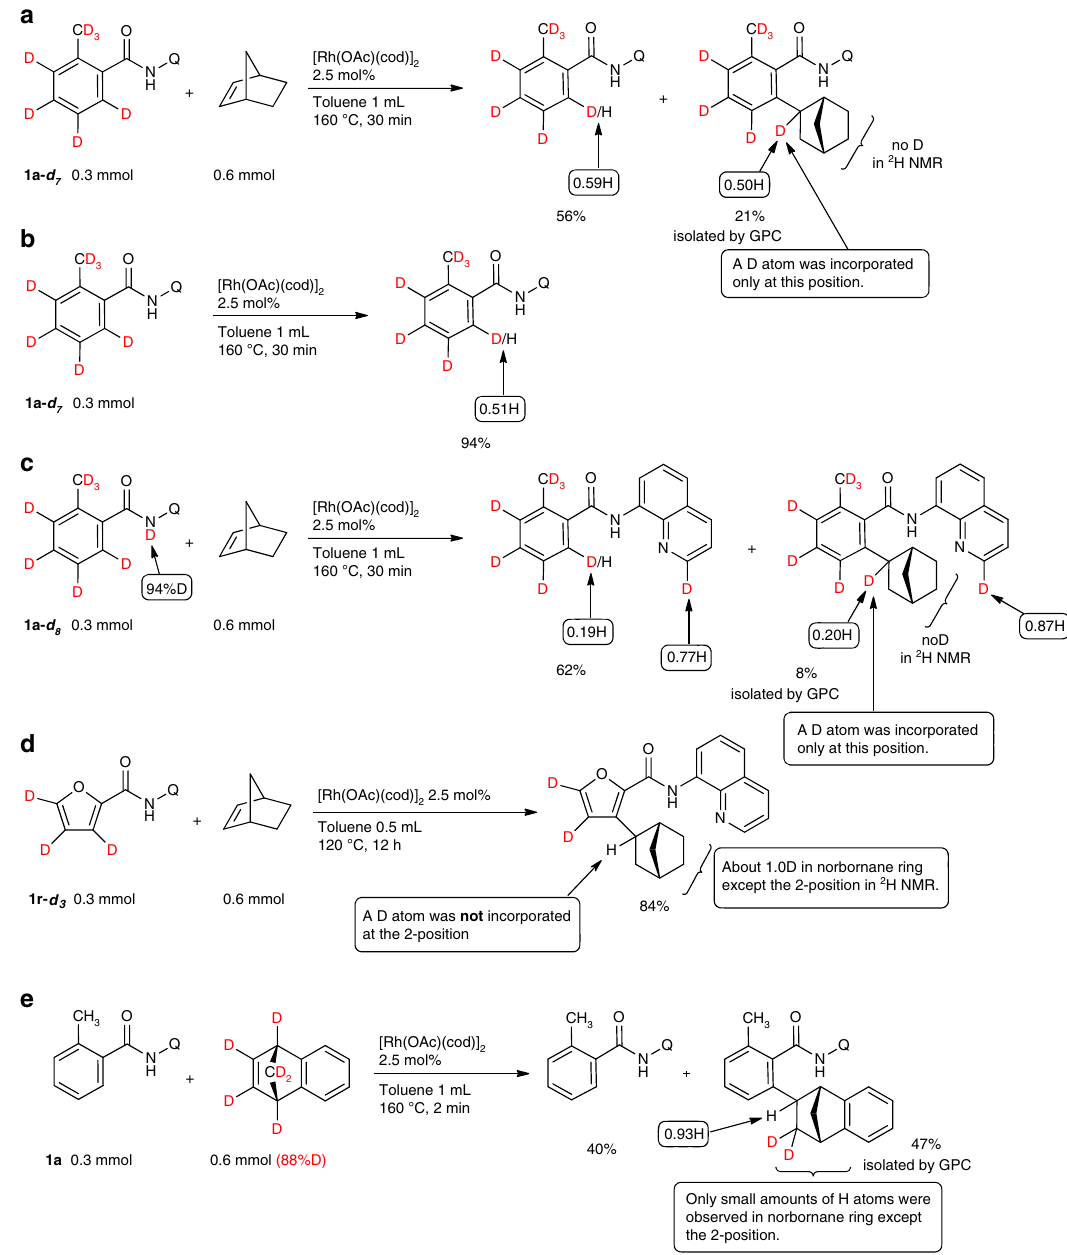
Fig. 5 Deuterium-labeling experiments. a – c A signi fi cant amount of H/D exchange occurred in the recovered amide, and both the ortho -carbon and the ortho -H of aromatic amides were attached to the 2-position of the norbornane ring in the product. d However, in sharp contrast to 1a , no deuterium incorporation was observed at the 2-position in the norbornane ring in the hydroarylation product obtained from 1r . e One of the deuterium atoms migrates to the adjacent